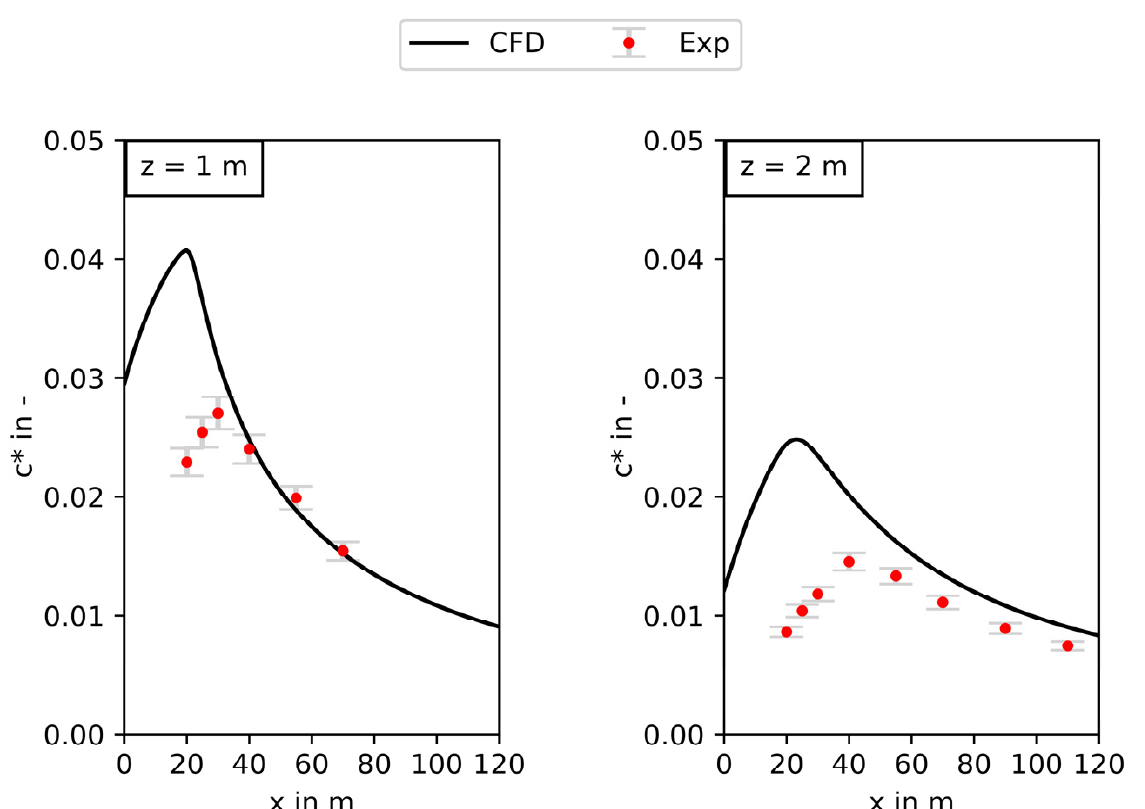
Figure 5. Neutrally buoyant gas cloud centerline profiles of the concentration over the distance to the source in 1 m height over ground ( left ) and 2 m height over ground ( right ).